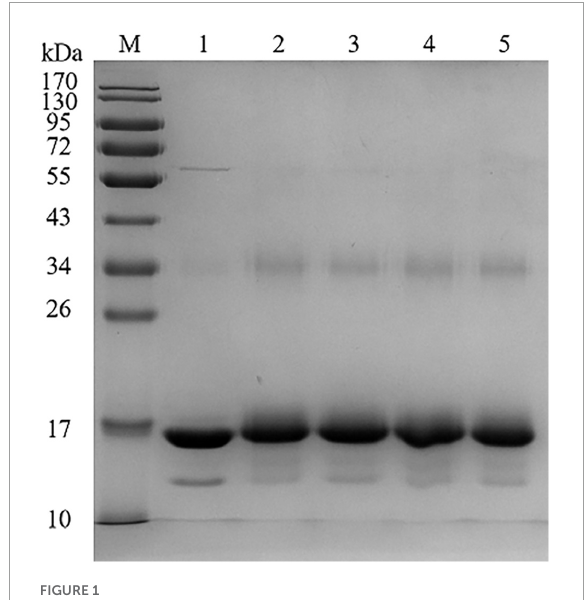
FIGURE1 Sodium dodecyl sulphate-polyacrylamide gel electrophoresis (SDS-PAGE) of BLG-catechin complexes (M: Marker; Lane 1: BLG; Lane 2: BLG-EC; Lane 3: BLG-ECG; Lane 4: BLG-EGC; Lane